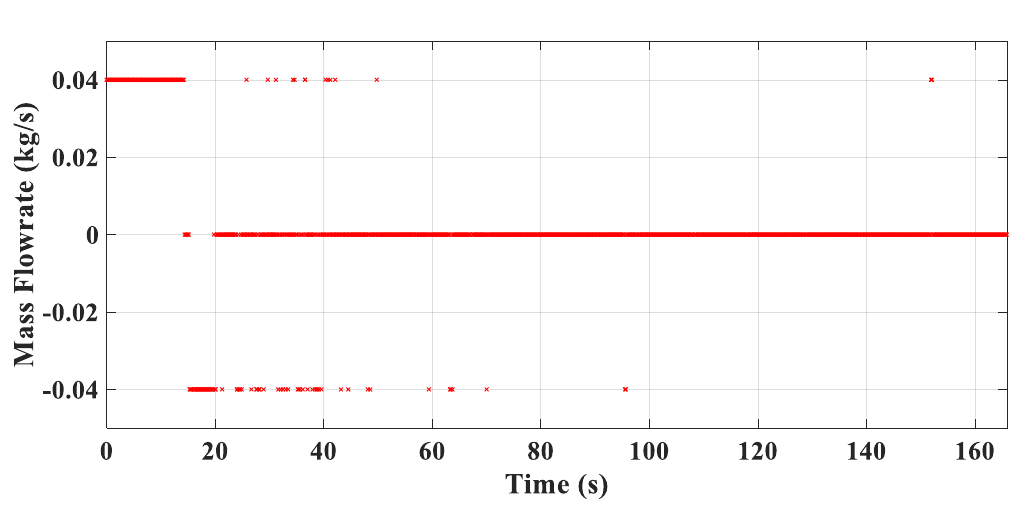
J. Mar. Sci. Eng. 2020 , 8 , 181 Figure 10. Mass flowrate of hovering control via on-off type VBS. Figure 10. Mass flowrate of hovering control via on-o ff type VBS.